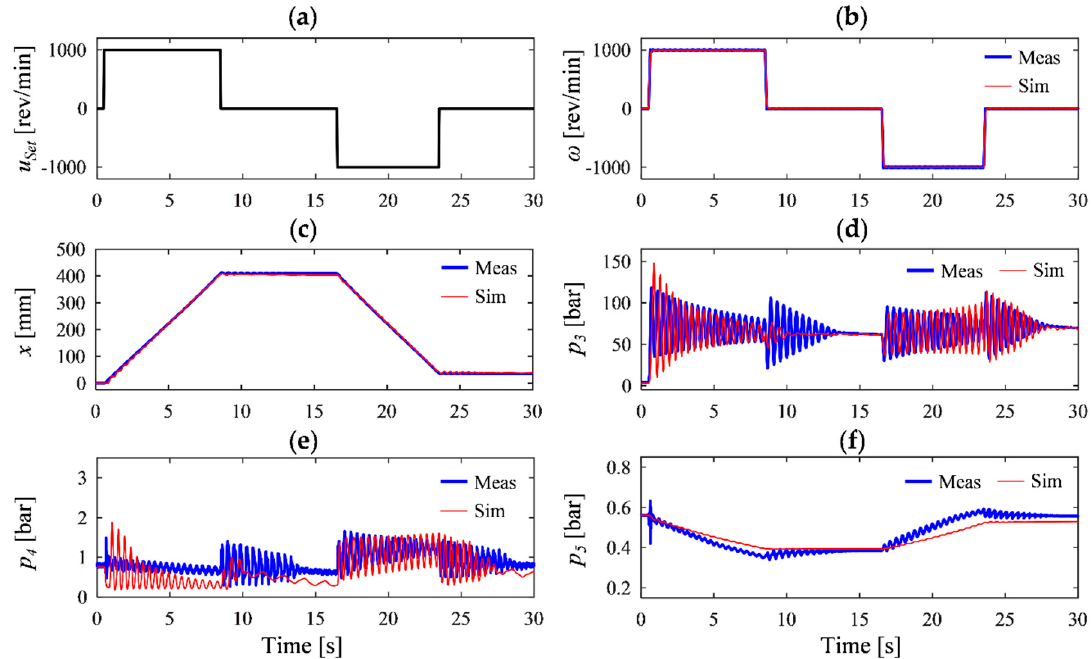
Figure 8. Experimental model validation: ( a ) Commanded motor speed; ( b ) motor speed; ( c ) piston position; ( d ) actuator’s bore-side pressure; ( e ) actuator’s rod-side pressure; and ( f ) accumulator pressure.